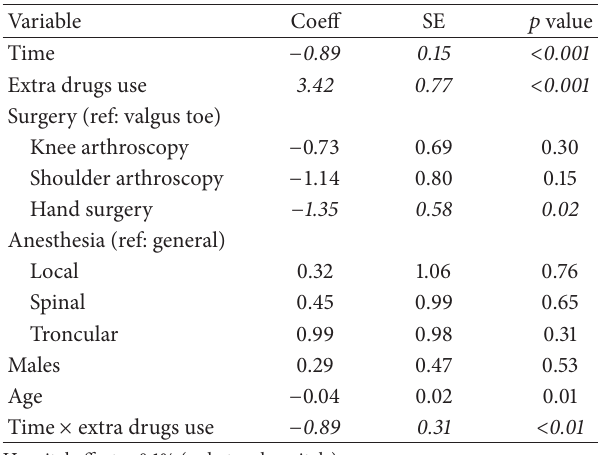
Table 5: Regression analysis with mixed effect models for postop- erative pain over